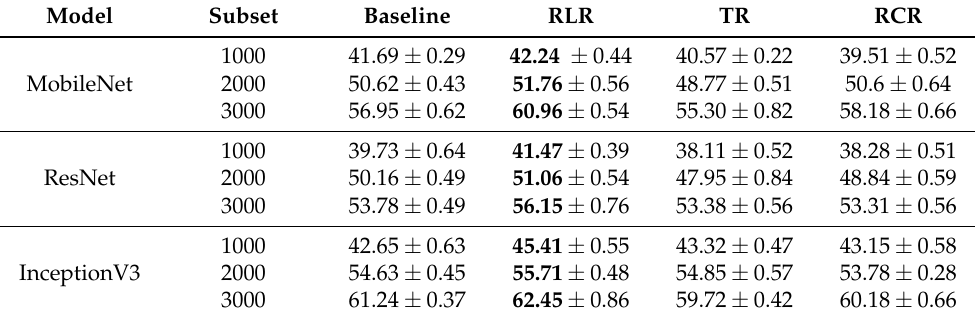
Table 3. Classification accuracy comparison between the TR, RCR and RLR data augmentation techniques. CNN models, i.e., MobileNet, ResNet and InceptionV3, with the data augmentation techniques, were applied on three different CIFAR-10 subsets, with numbers of samples of 1000, 2000 and 3000, respectively. The results indicated the superior performance of the proposed RLR technique.